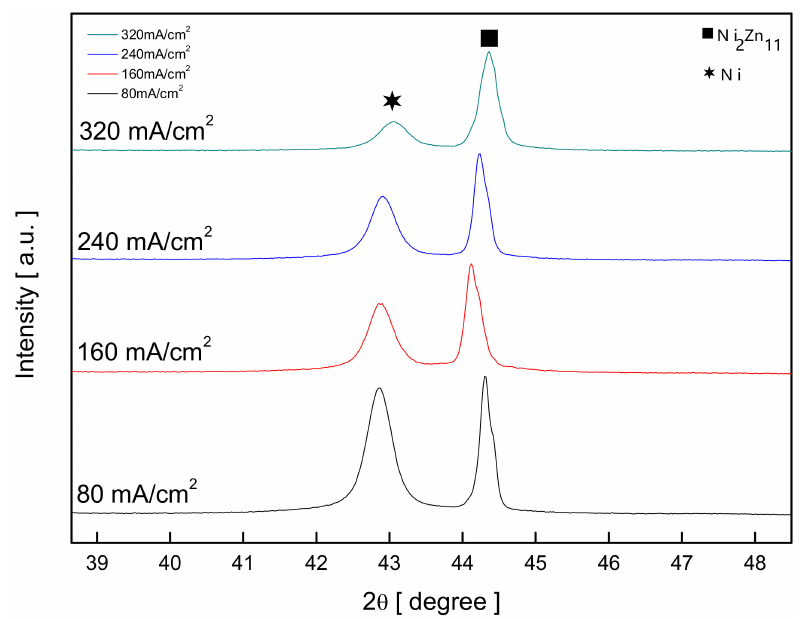
Figure 6. XRD patterns of Ni–Zn–Fe electrode surface on a Ni-foam bath (E) with different plating current densities before Zn dealloying.